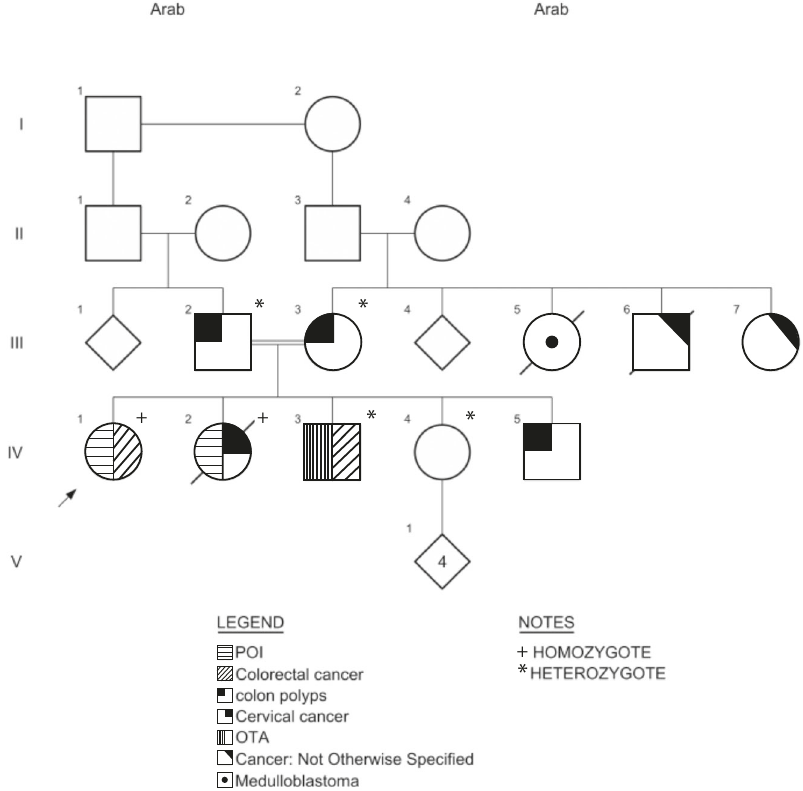
Fig. 1 MCM9 mutated pedigree. Clinical manifestations, polyps, and cancers are indicated. Genotypes are indicated as: + for homozygotes; * for heterozygotes. Tumor spectrum included cancer — not otherwise speci fi ed, cervical cancer, colon polyps, colorectal cancer, medulloblastoma, oligo-terato-asthenozoospermia (OTA), and primary ovarian insuf fi ciency